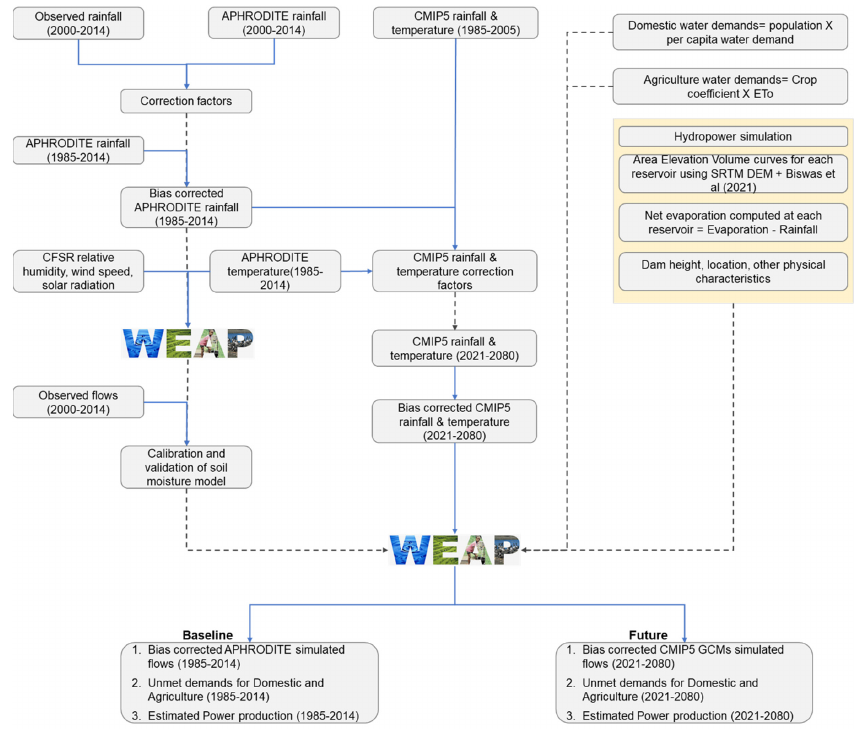
Figure 2. Overall methodology adopted in this study.